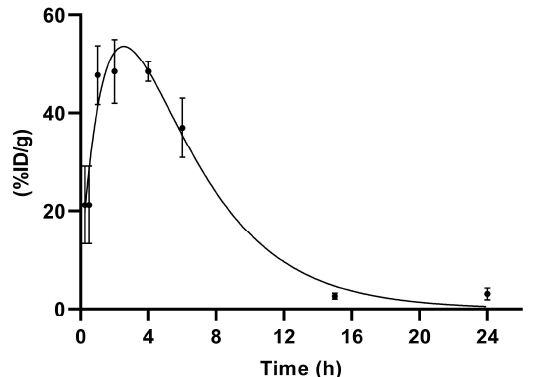
Figure 6. Renal excretion of [ 99m Tc]Tc-PSMA-T4 ( n = 5) in healthy male Wistar rats.